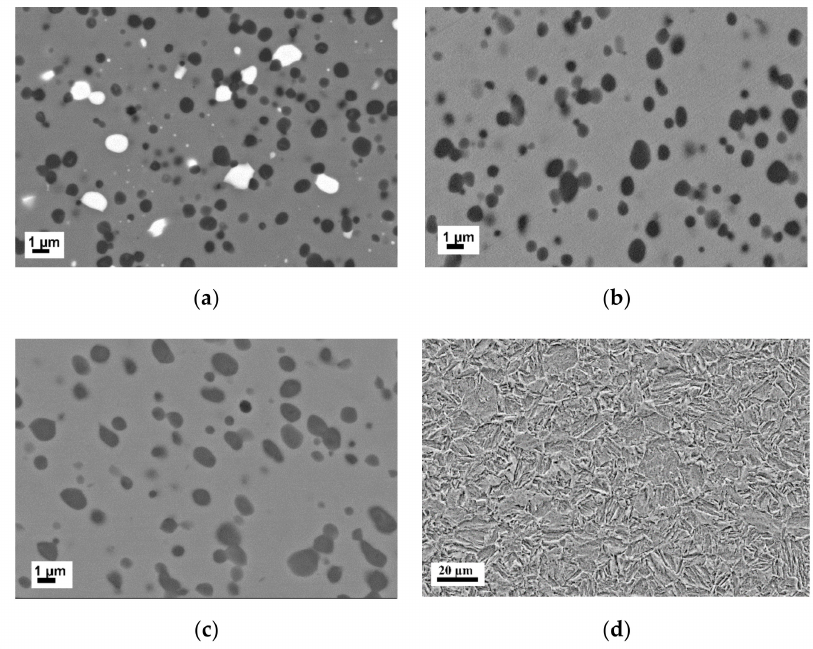
Figure 1. The tested tool steels’ microstructure and sheet microstructure, ( a ) V40, ( b ) VSC, ( c ) V8SC and ( d )